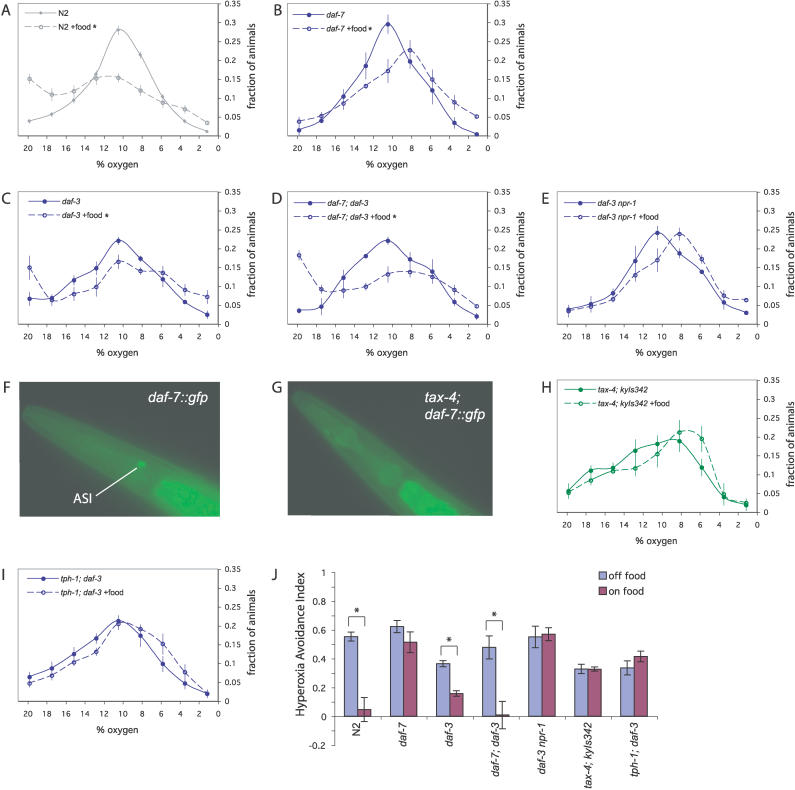
TGF-β Signaling Mediates Food Suppression of Hyperoxia Avoidance(A–E), (H), (I) In all panels, dotted lines indicate aerotaxis in the presence of a small amount of bacterial food. (A) Aerotaxis of wild-type N2 animals. (B) Aerotaxis of daf-7 mutants. (C) Aerotaxis of daf-3 mutants. (D) Aerotaxis of daf-7; daf-3 double mutants. (E) Aerotaxis of daf-3 npr-1 double mutants. (F–G) daf-7::GFP expression in ASI was reduced in a tax-4 mutant. Anterior is to the left. (H) Aerotaxis of tax-4; kyIs342 animals, which bear a transgene that rescues tax-4 in URX, AQR, and PQR, but not in ASI or other neurons. (I) Aerotaxis of tph-1; daf-3 double mutants. For (A–E), (H), and (I), asterisks denote distributions different by chi-square analysis at p < 0.01 from the same genotype without food. n ≥ 3 assays per genotype and condition, 80–100 animals/assay. Error bars denote SEM. (J) Hyperoxia avoidance index as defined in Figure 1. Asterisks, values significantly different from the same genotype without food at p < 0.05 by t test. In the absence of food, no strain is different from N2 controls by Dunnett test. In the presence of food, daf-7, daf-3 npr-1, and tph-1; daf-3 are different from N2 at p < 0.01 and tax-4; kyIs342 different from N2 at p < 0.05 by Dunnett test. Error bars denote SEM.